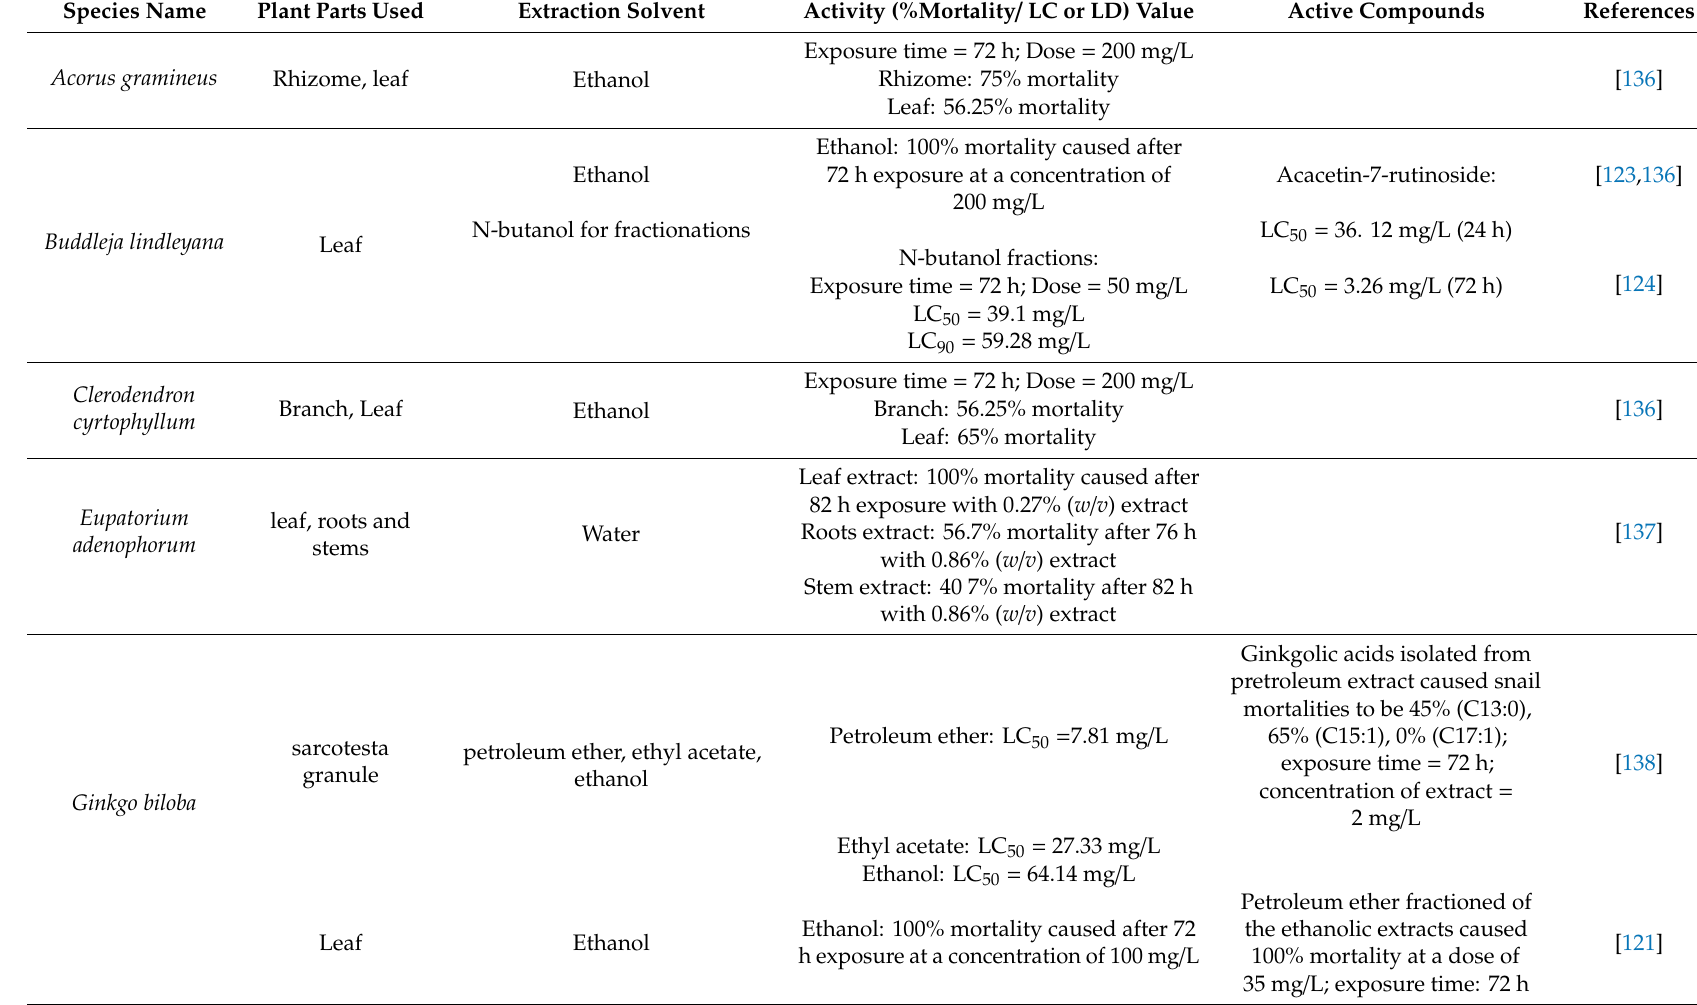
Table 6. Molluscicidal activities of medicinal plants from China against Oncomelania hupensis , the intermediate host of Schistosomiasis